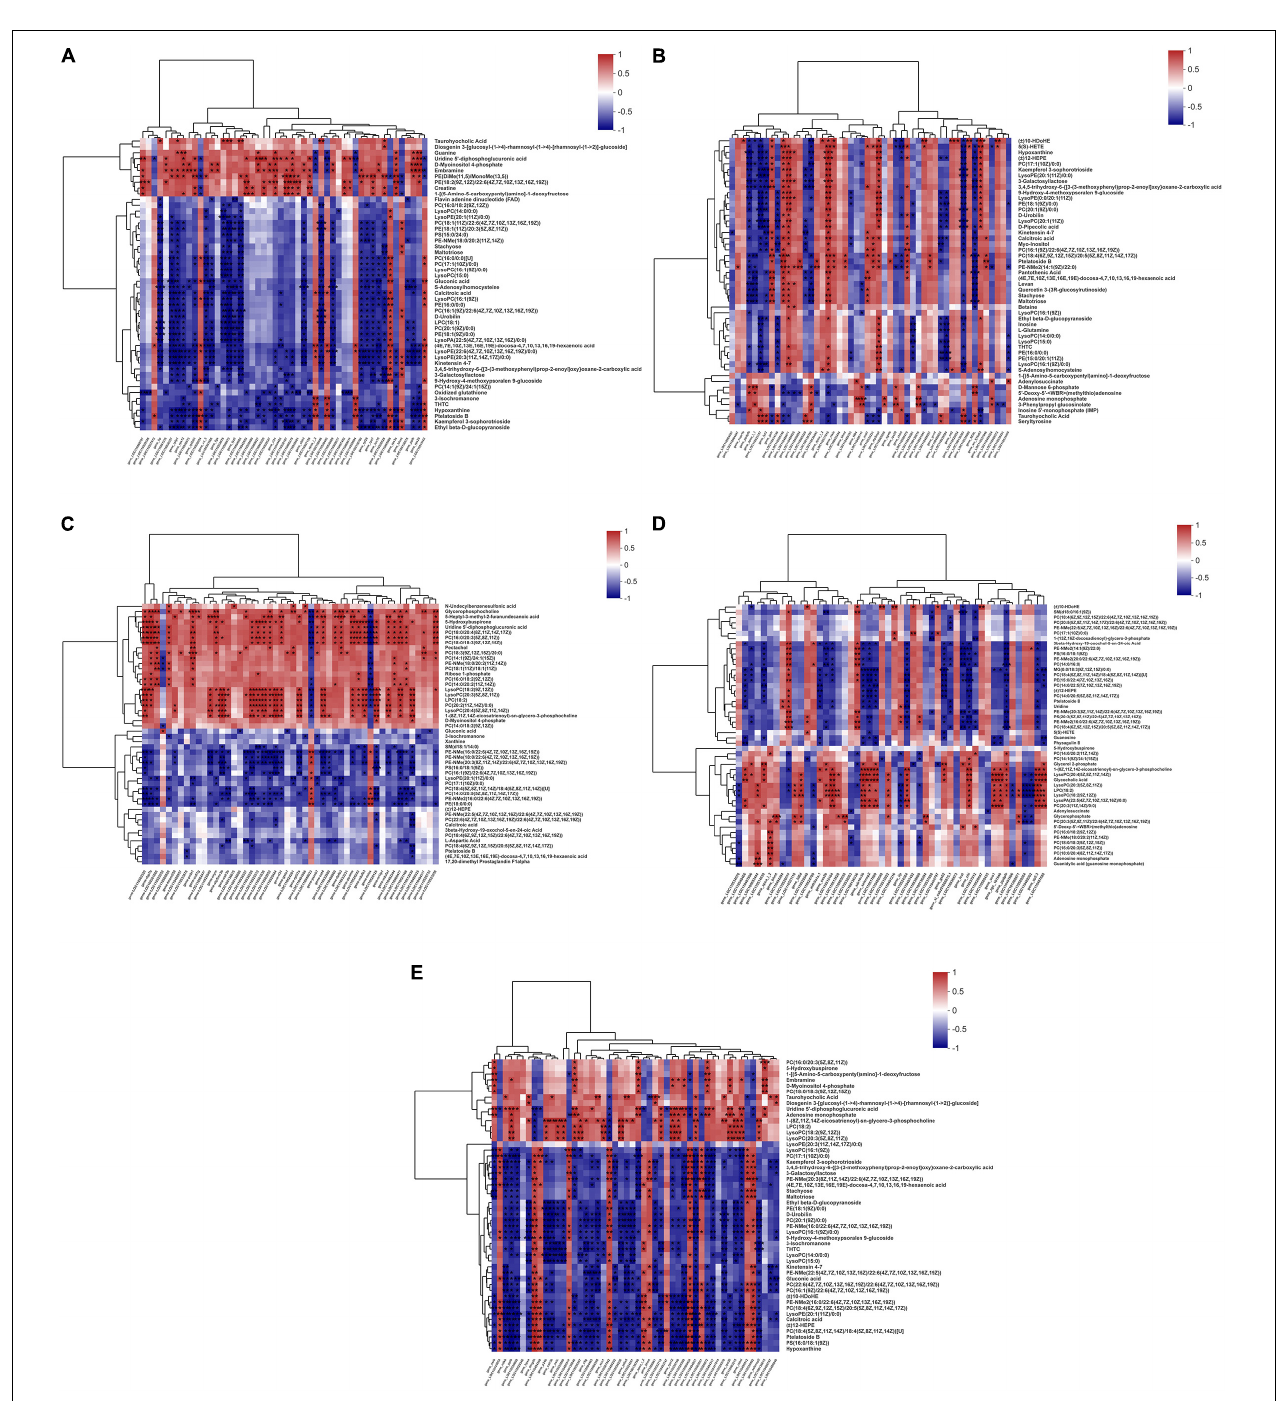
FIGURE 4 | Correlation plots of the correlations between metabolome and transcriptome. The correlation plots with genes in columns and metabolites in rows to reveal the connection between genes and metabolites of O. mykiss fed diets with FM replacement (A,B) , FO replacement (C,D) , and combined replacement FM and FO (E) . The red and blue showed the positive and negative correlation between transcriptomics and metabolomics, respectively. The symbol “*” indicates significant correlation between the gene and metabolites ( P < 0.05).